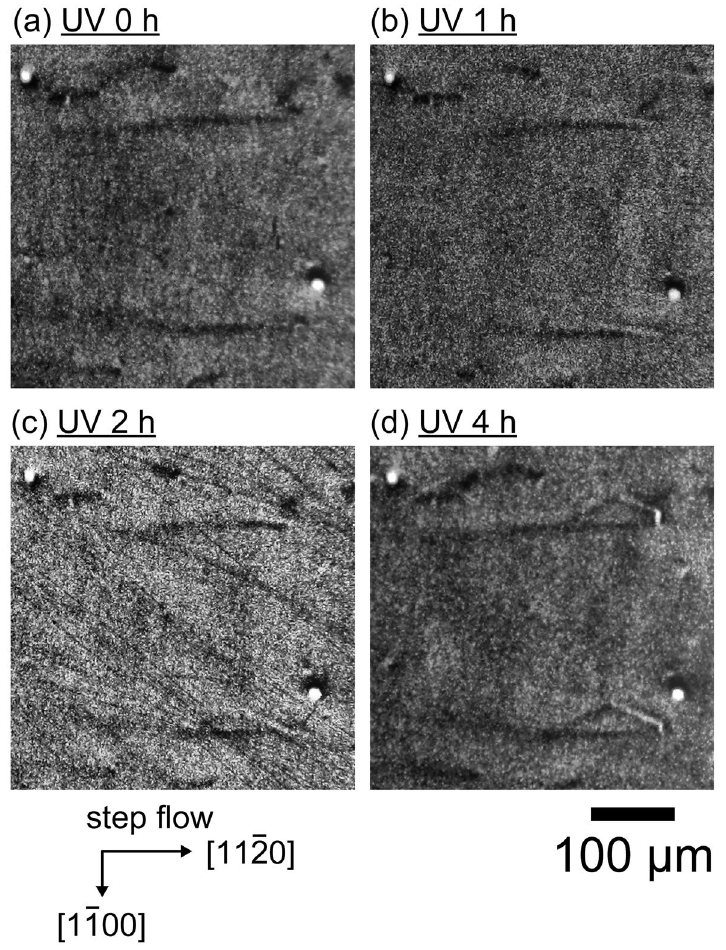
Figure 3. X-ray topography images of specimen without proton irradiation with different UV illumination times (a: 0 h, b: 1 h, c: 2 h, d: 4 h) with a power density of 10 W cm −2 at 373